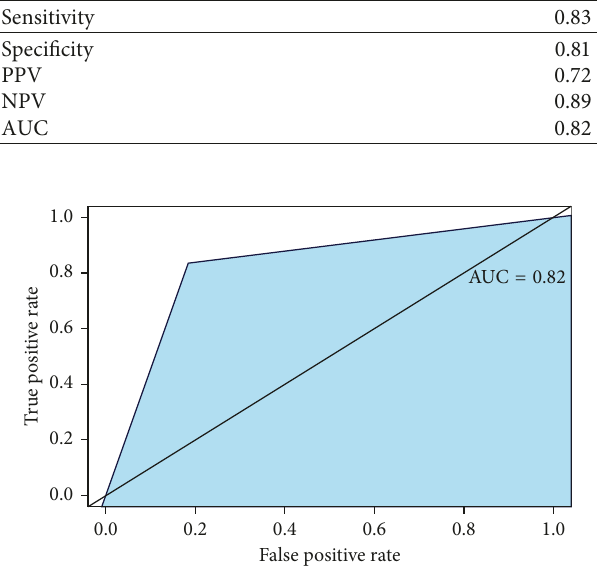
Figure 4: The ROC curve.